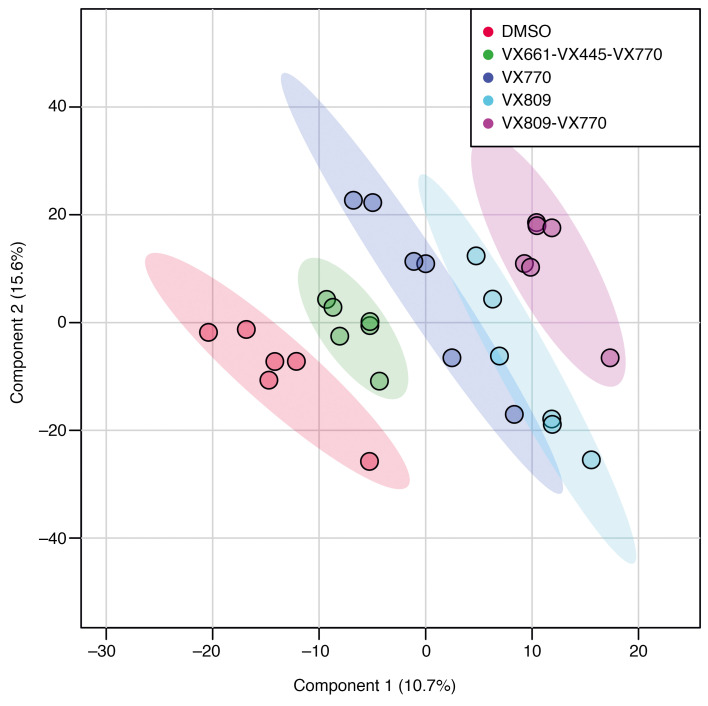
Score plot for PLS-DA analysis of CFBE41o- cells lipidome after treatment with drugs or control DMSO.Blank and QC groups are omitted for clarity.